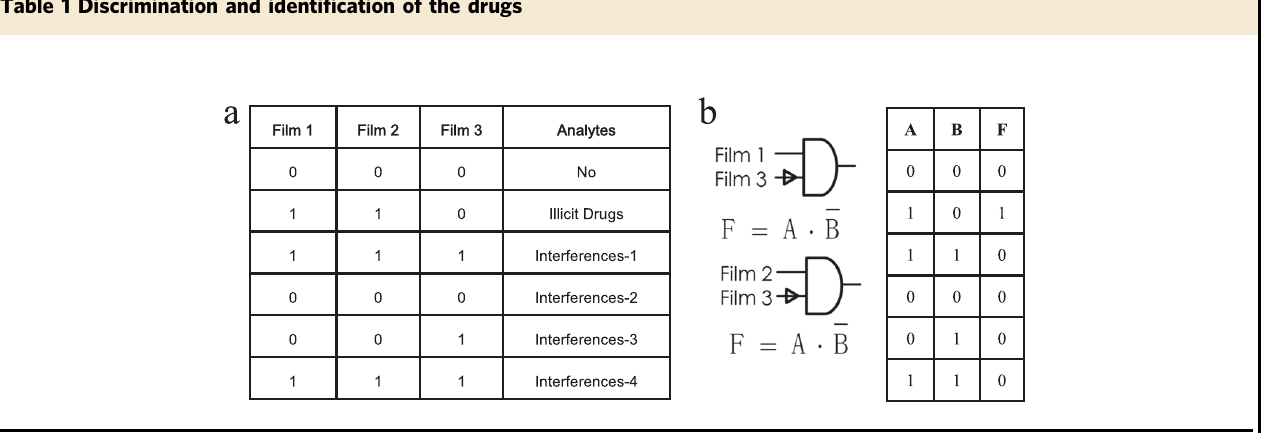
a The truth table of the responses recorded as shown in Fig. 3, where positive response no matter quenching or sensitizing is counted as “ 1 ” , and no response as “ 0 ” . b The logic gates formed with any two of the three fi lms Note: interferences-1: 7 – 13; interferences-2: 14, 15, 23; interferences-3: 16 – 22; interferences-4: 24 – 26 1. Methamphetamine; 2. ecstasy; 3. magu; 4. caffeine; 5. phenobarbital; 6. ketamine; 7. water; 8. shampoo; 9. cream; 10. hair conditioner; 11. apple; 12. pear; 13. banana; 14. dirt clothes; 15. glycine; 16. tryptophan; 17. lysine; 18. glutamic acid; 19. histidine; 20. atorvastatin calcium tablets; 21. dextromethorphan; 22. tryptamine; 23. dopamine; 24. benzylamine; 25. ethylhexylamine; 26.